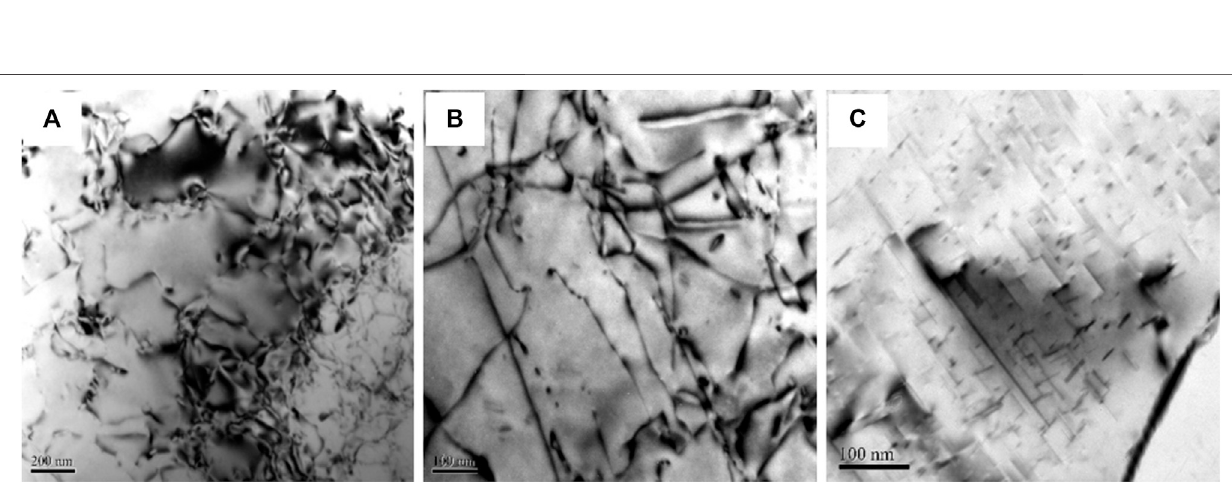
Frontiers in Materials |